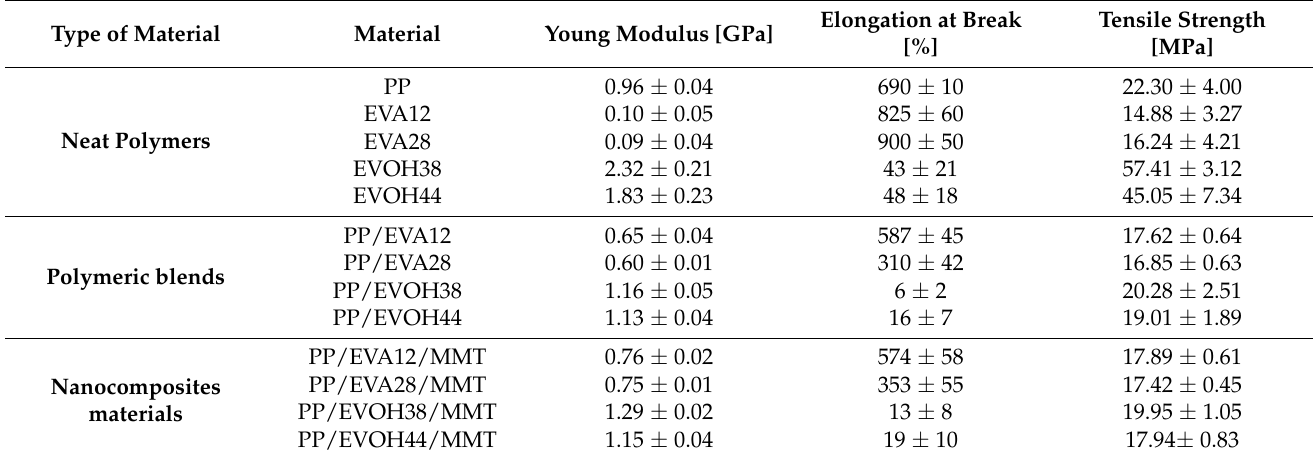
Table 3. Mechanical properties (Young modulus, elongation at break and tensile strength) of polymeric blends and nanocomposites